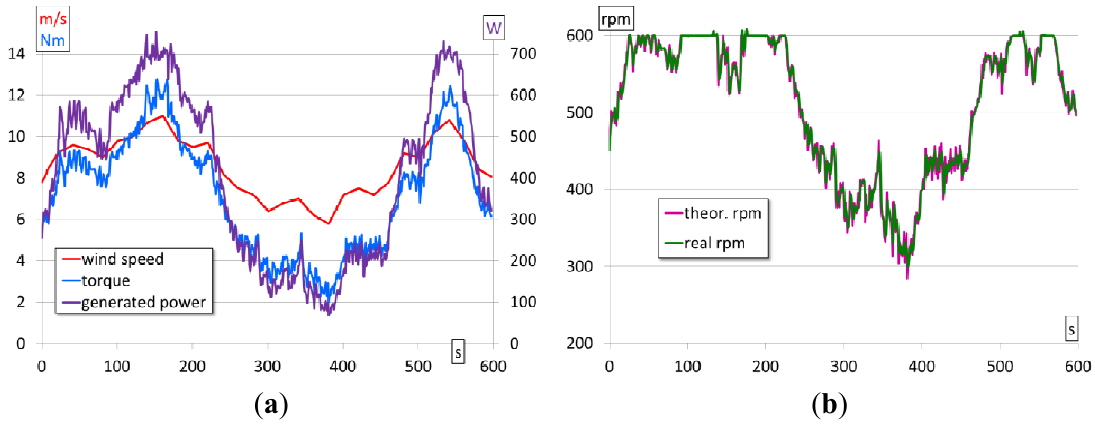
Figure 9. ( a ) Wind speed sample, turbine torque and generated power; ( b ) Theoretical and real rotational speed of the